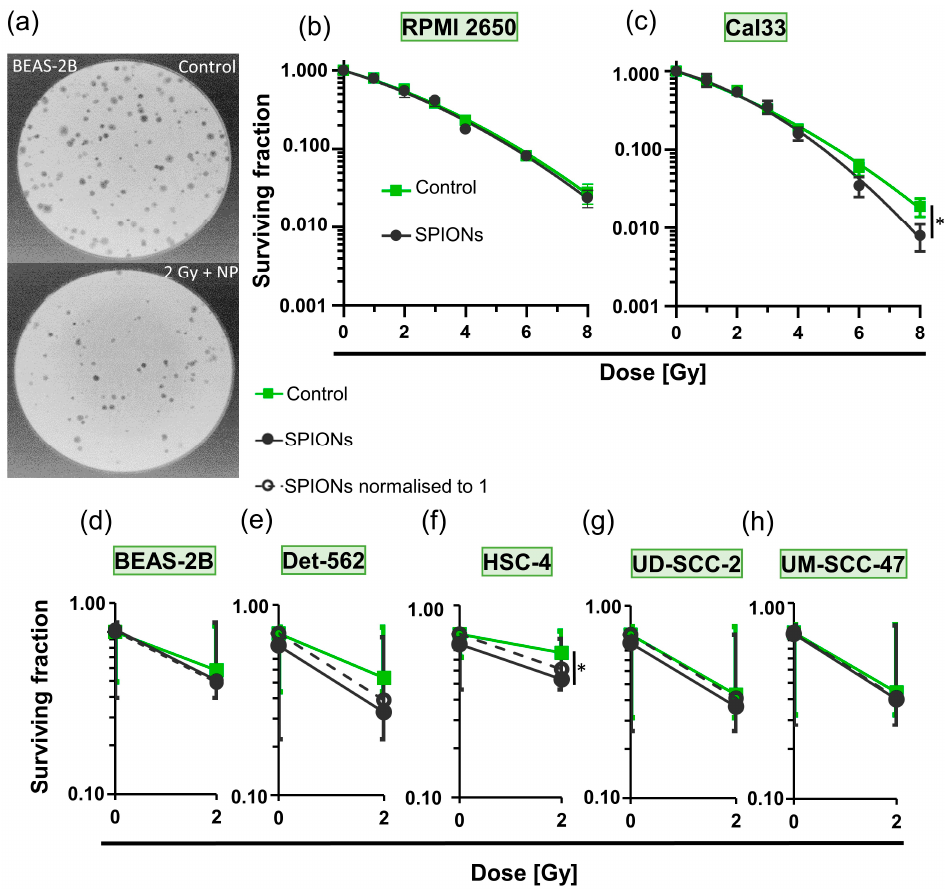
Figure 5. Detection of cytotoxic effects of SPION-APTES via colony formation assays. ( a ) Representative images of stained BEAS-2B (healthy bronchial epithelium cell line) colonies in Petri dishes during colony formation assay; top: control, bottom: 2 Gy of ionizing radiation and 20 µg Fe/ml of SPIONs. Logarithmic plots of survival fraction of ( b ) RPMI 2650 and ( c ) Cal33 cells; control group without SPIONs (green) and treated group with 20 µg Fe/ml SPIONs (black); ionizing radiation doses from 0 to 8 Gy; * describes significance with p = 0.05 between control group and nanoparticle group at 8 Gy, determined by Mann–Whitney U-test. Logarithmic plots of surviving fraction at 0 and 2 Gy without SPIONs (green) and with 20 µg Fe/mL of SPIONs (black); dashed lines represent nanoparticle groups normalized to 1; cell lines ( d ) BEAS-2B; ( e ) Detroit 562 (Det 562); ( f ) HSC-4; * describes significance with p = 0.05 between control group and nanoparticle group at 2 Gy, determined by Mann–Whitney U-test; ( g ) UD-SCC-2; ( h ) UM-SCC-47.